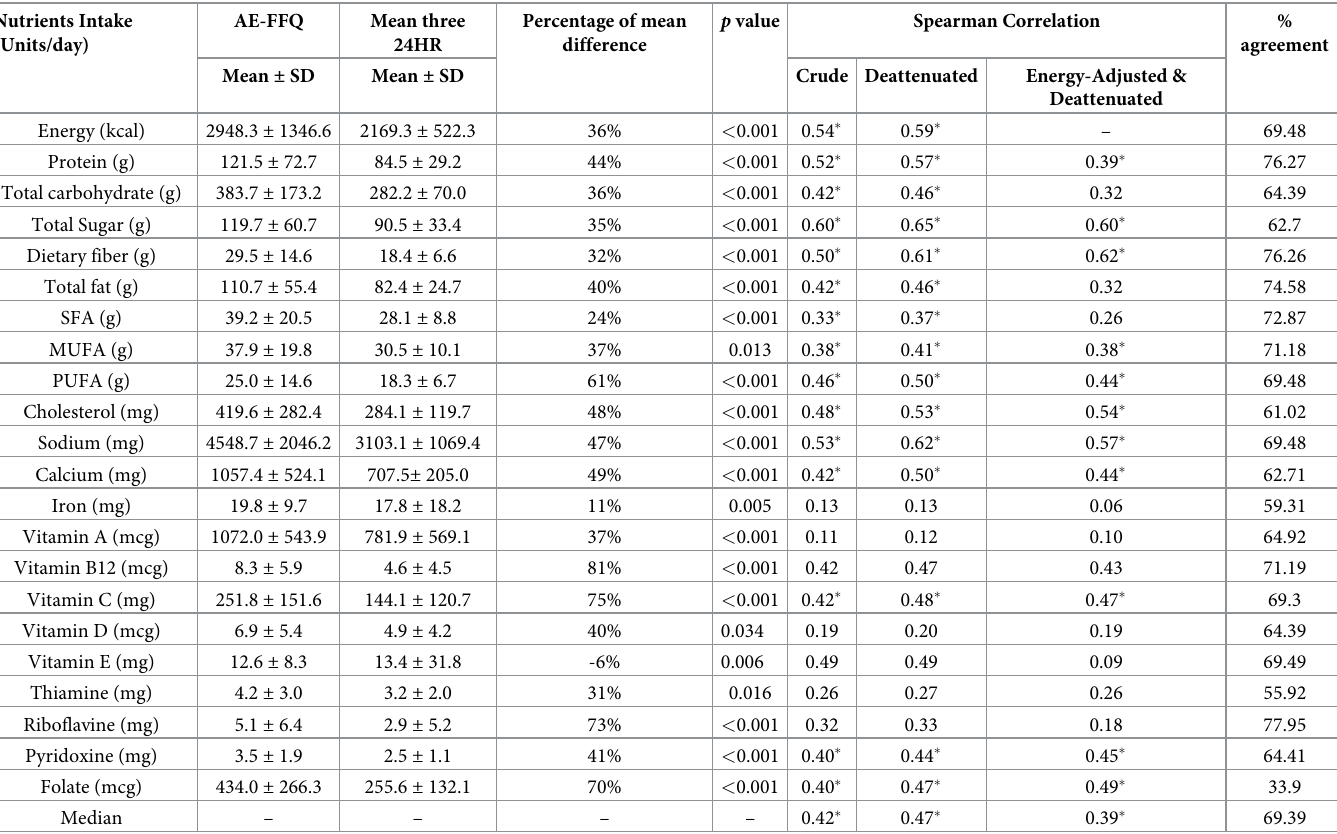
Table 4. Mean daily nutrient intakes, Spearman correlation coefficients and % agreement from the average of three 24HRs and the AE-FFQ (n =